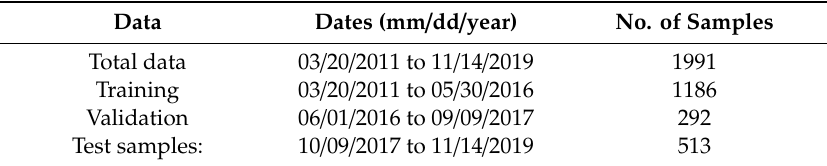
Table 4. Training and test data distribution.